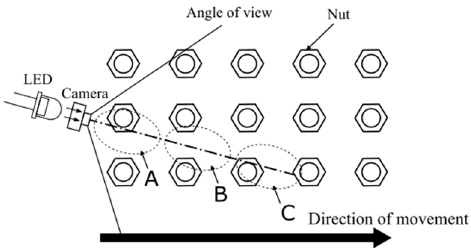
Figure 15. Position of each nut shown in the camera that changes based on the irradiation position of the LED (from A to C).